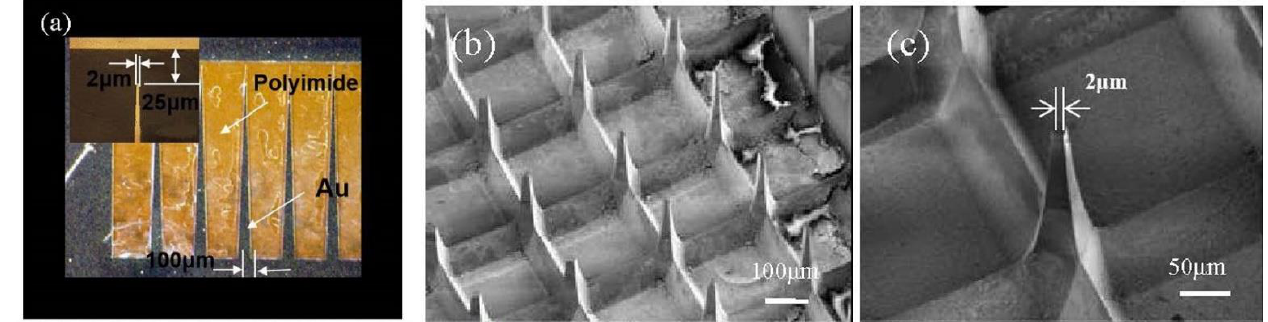
Figure 7. Fabrication results of metal nickel MNA. ( a ) Pattern and size of mask. ( b ) Metal nickel MNA. ( c ) An enlarged image of ( b ).